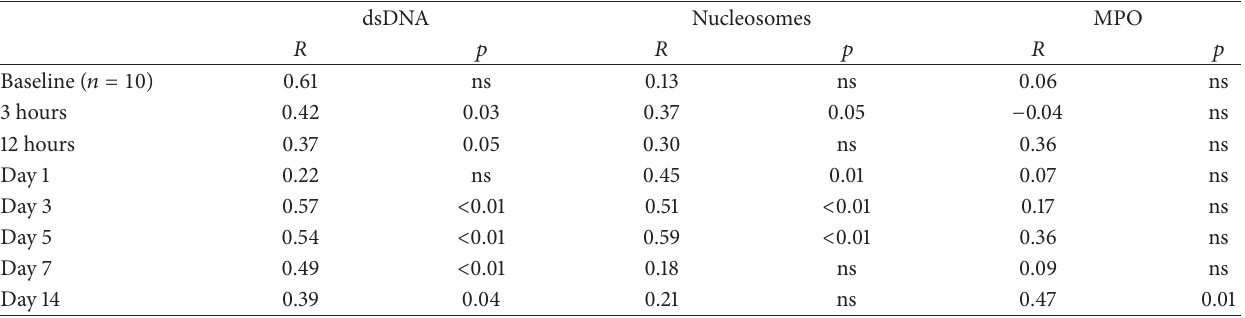
Table 3: Correlation between markers of NETs, MPO, and total leukocyte count at corresponding time points in the total study population ( 𝑛 = 30